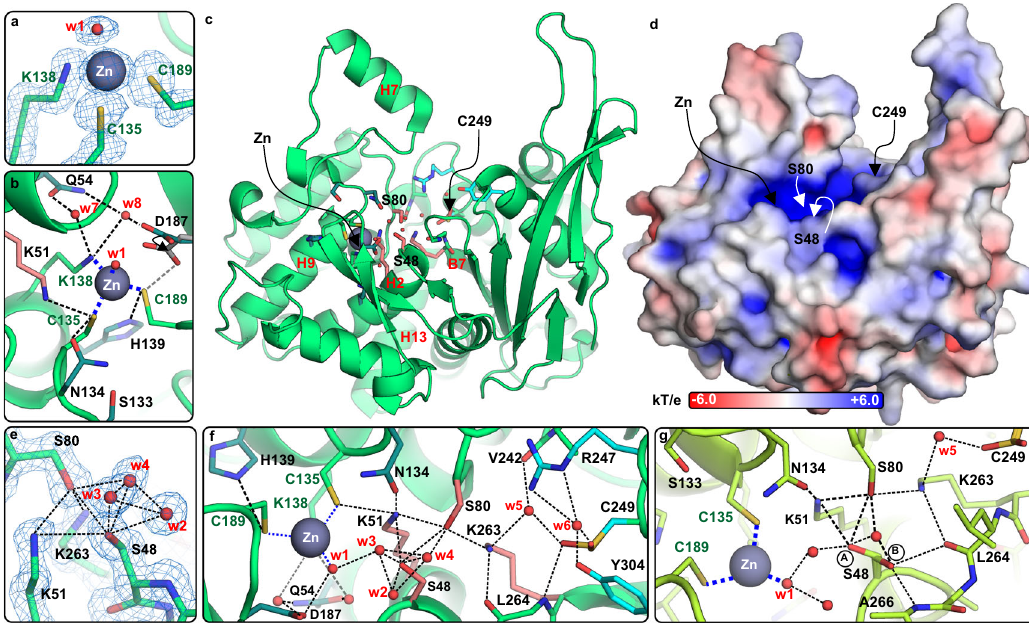
Fig. 3 Detailed view of the active site area. Panels a – f correspond to the highest resolution (1.29 Å) structure OP, while ( g ) shows structure MP2. a 2Fo- Fc electron density (contour level 1.50 σ ) at the Zn coordination sphere. b Hydrogen bonds (black dashed lines) involving residues participating in Zn coordination (thick dotted blue lines); alternative conformations of D187 were visible only in the OP structure. c Overall structure of the ReAV protomer with residues creating the active site in stick representation. d Surface electrostatic potential with the strongest positive charge (blue) visible in the active site area. e 2Fo-Fc electron density (contour level 1.50 σ ) around Ser48 and the water triad w2-w3-w4. f A detailed map of the most important hydrogen bonds in the active site. g Ser48 observed in two conformations (circled A and B) in structure MP2, where the water triad is